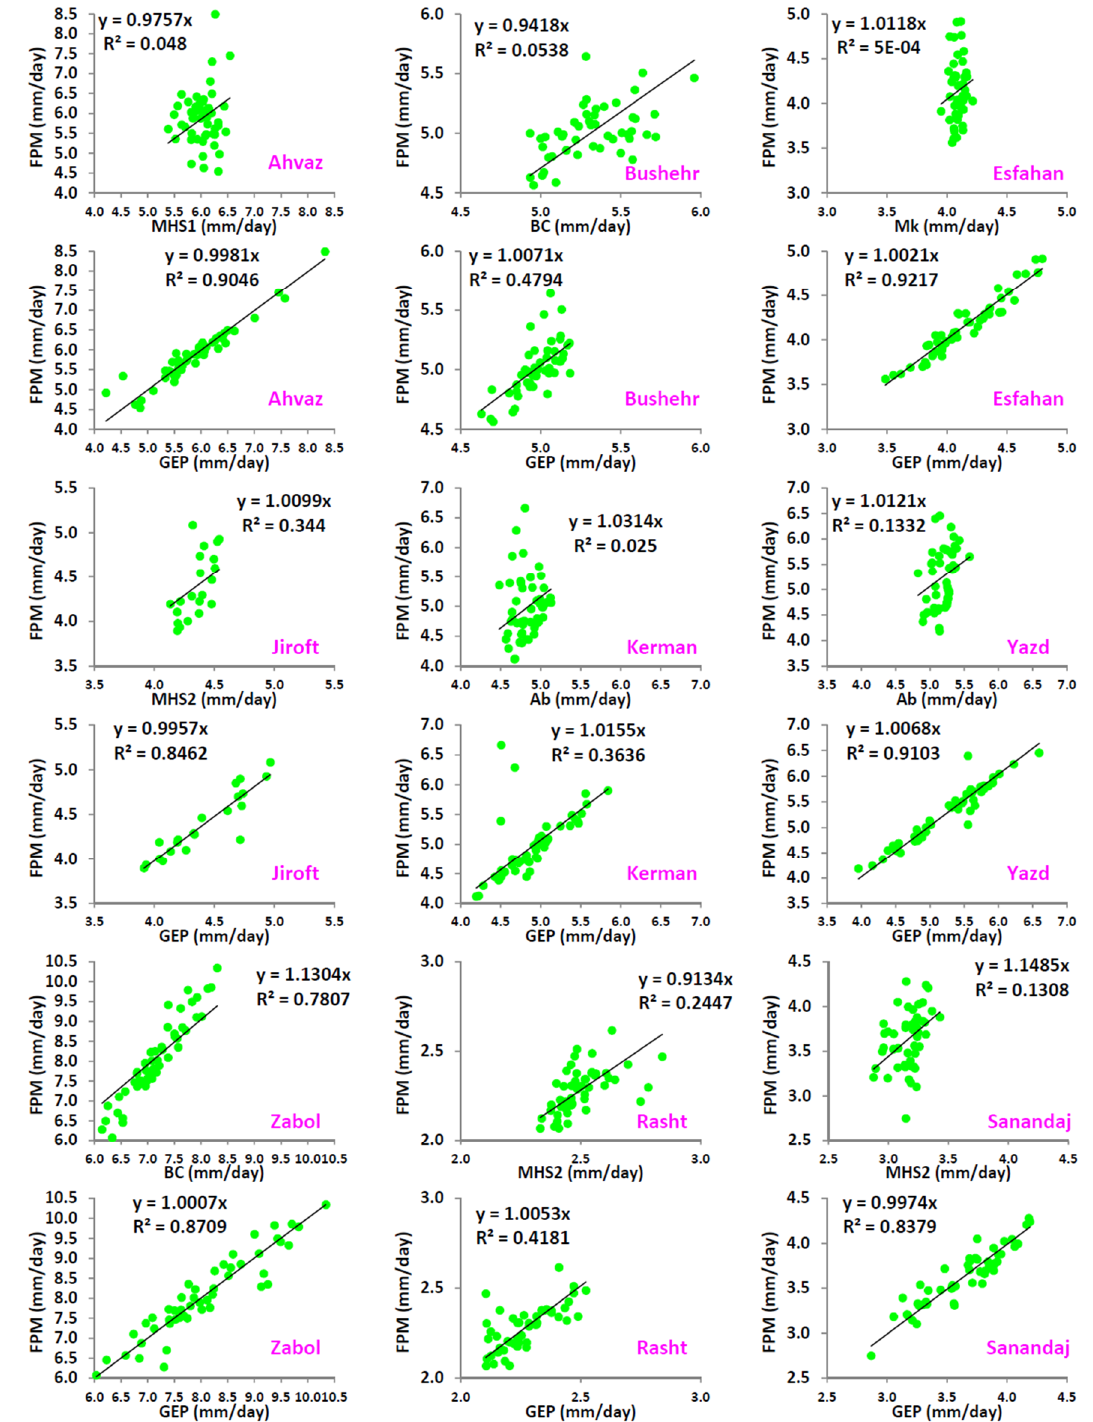
Figure 2. Accuracy of empirical models (annual mean ETo) against gene expression programming (GEP) in very humid (Rasht), Mediterranean (Sanandaj), and arid (other stations) climates.